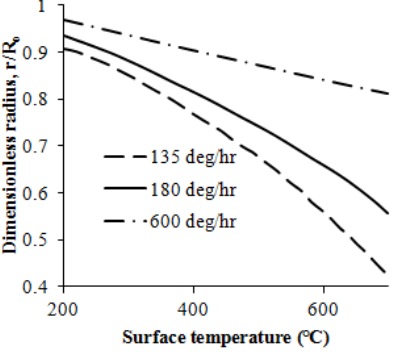
Figure 39. Effect of the heating rate on the location of the drying front [74].